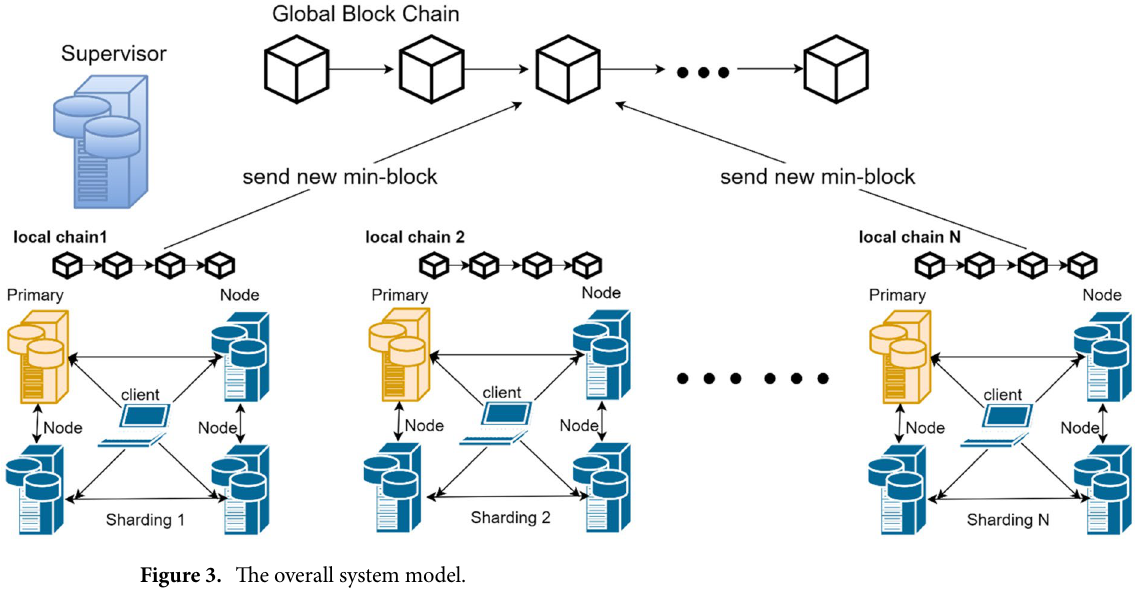
Figure 3. The overall system